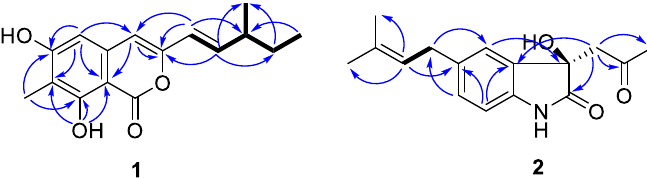
Figure 2. Key 1 H- 1 H COSY (bold) and HMBC (solid arrows, blue) correlations of compounds 1 and 2 .